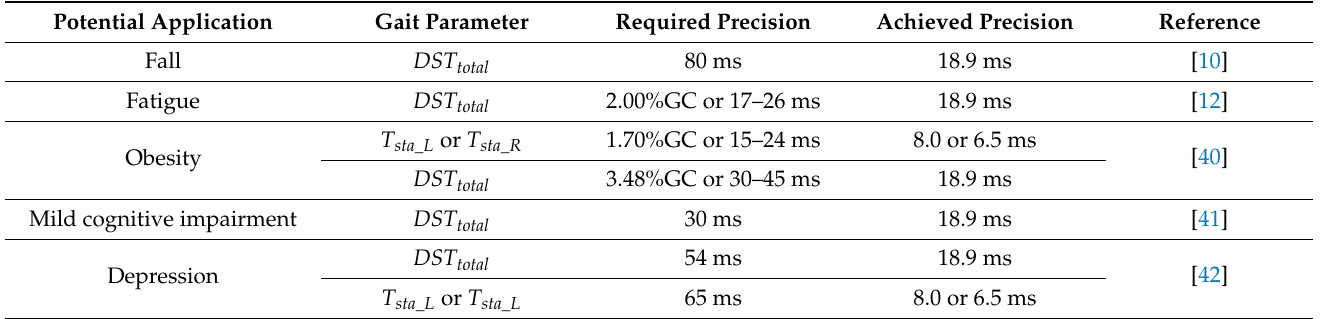
Table 4. Potential applications and required estimation precisions for gait parameters measured by an